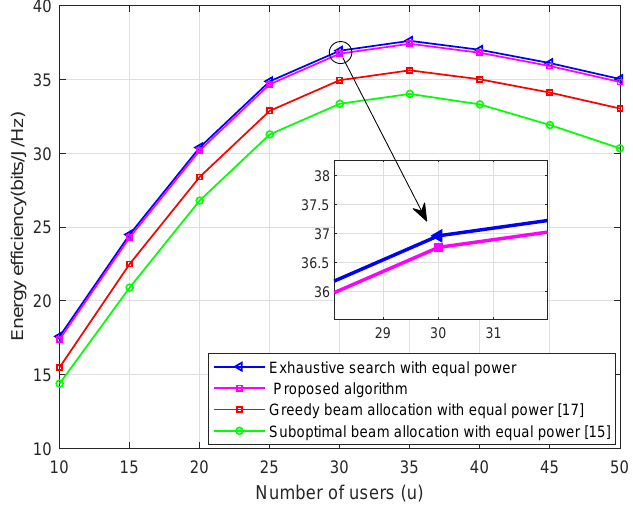
Figure 3. EE versus the number of users with α = 2, P t = 30